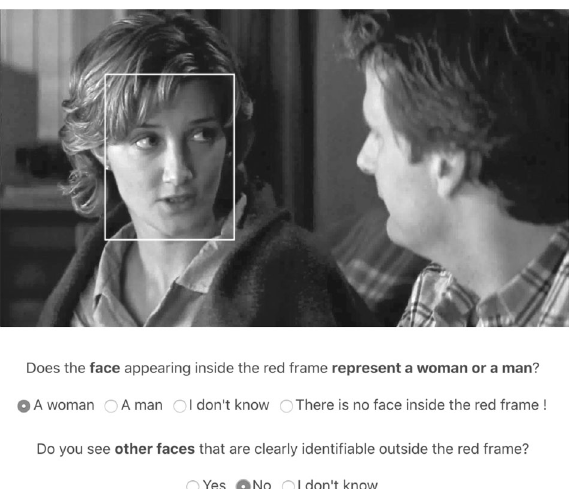
Fig. 1 Interface of the human evaluation experiment. A randomly-selected image is displayed to users on top of the two closed questions they are requested to answer.